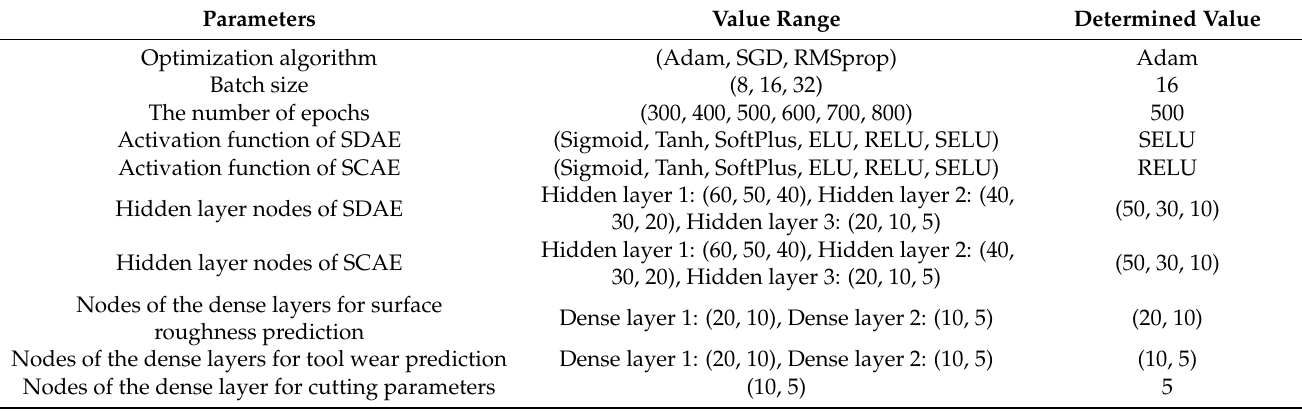
Table 1. Hyper-parameters of the proposed MTL